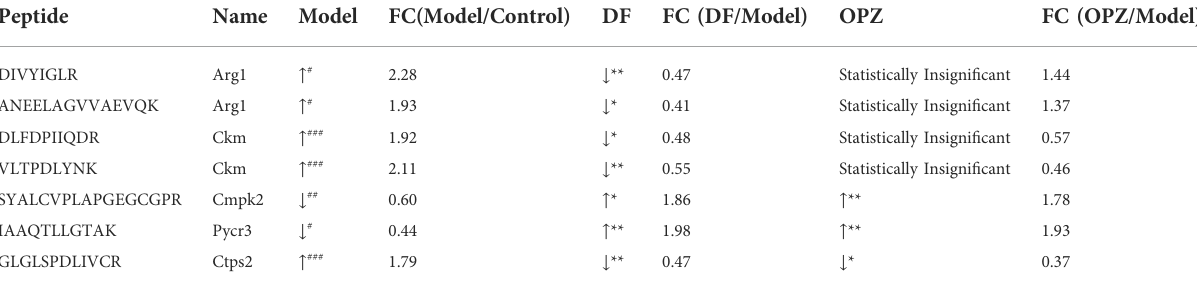
TABLE 1 PRM relative quantitative veri fi cation results of some differential proteins.